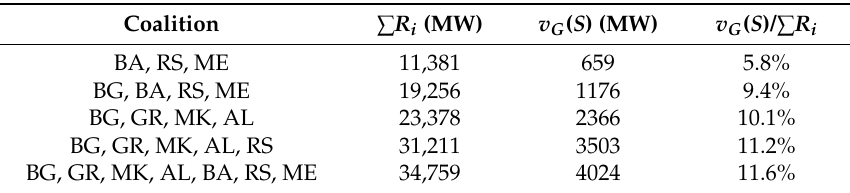
Table 8. Benefits of selected coalitions in SEE